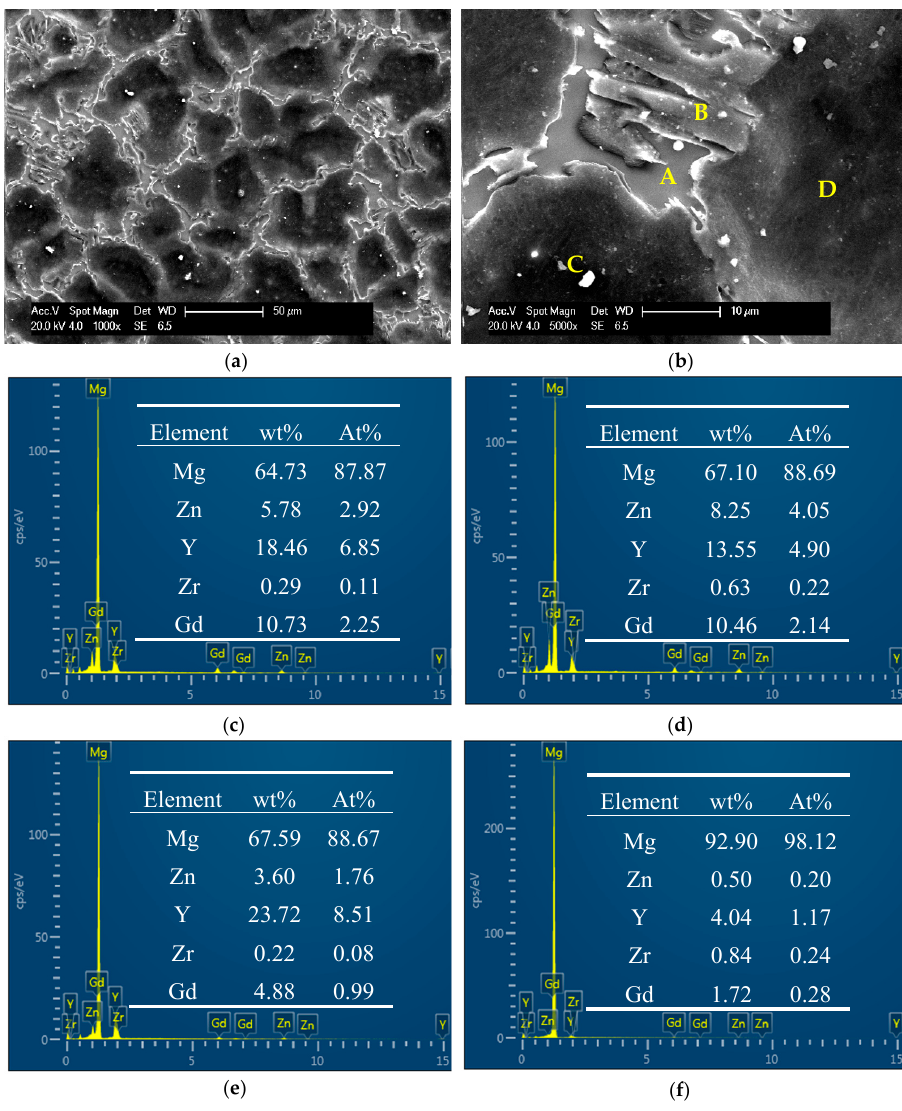
Figure 2. SEM images of as-cast Mg-10Y-6Gd-1.5Zn-0.5Zr alloy at low ( a ) and high ( b ) magnifications and EDS results of areas A ( c ), B ( d ), C ( e ) and D ( f ) marked in Figure